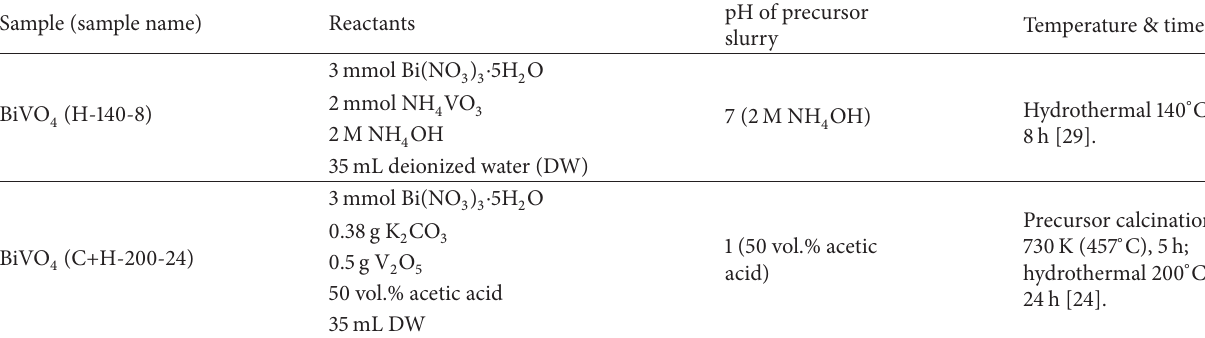
Table 1: Synthesis parameters of BiVO 4 samples prepared via hydrothermal